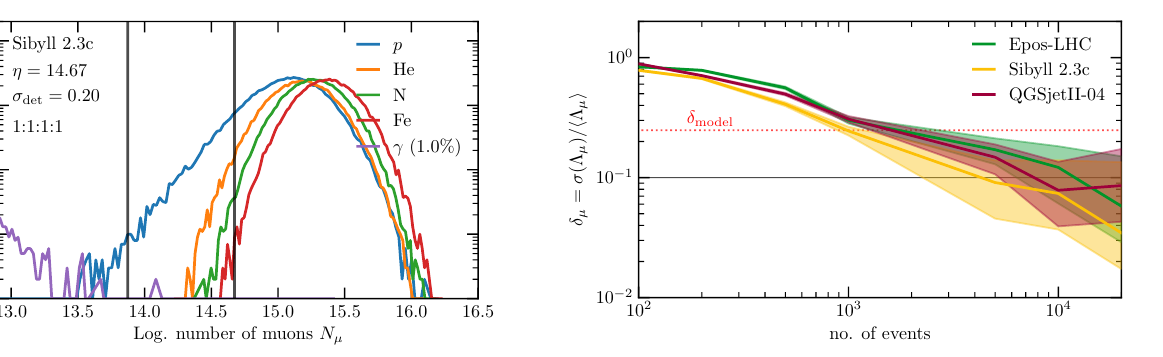
Figure 7. Distributions of ln N µ for proton, helium, nitrogen and iron induced air showers. The primary energy is 10 19 eV.